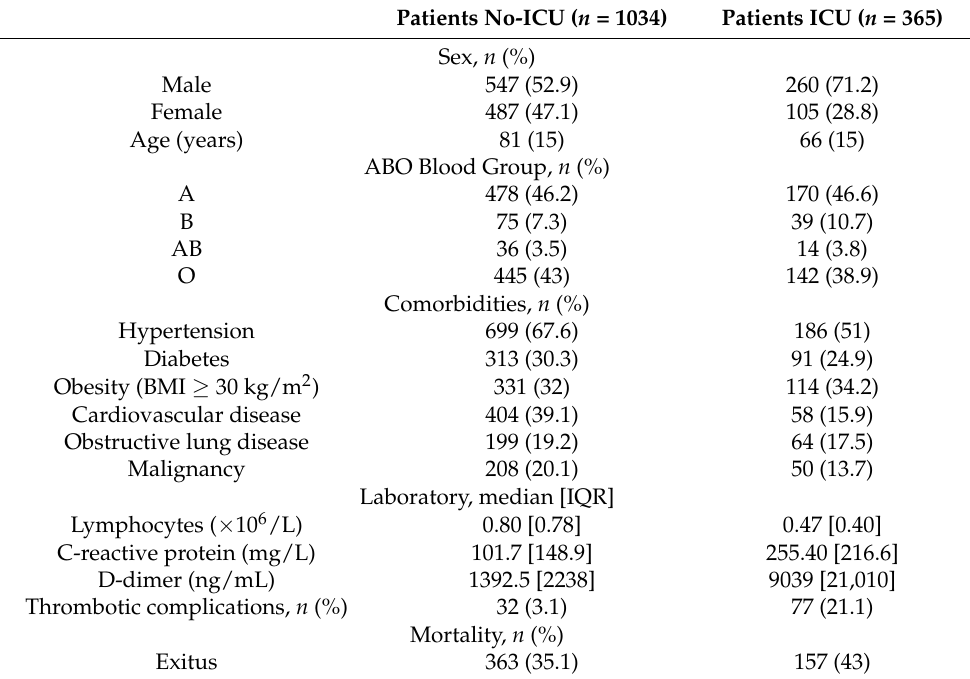
Table 1. Characteristics of patients with COVID-19 infection.